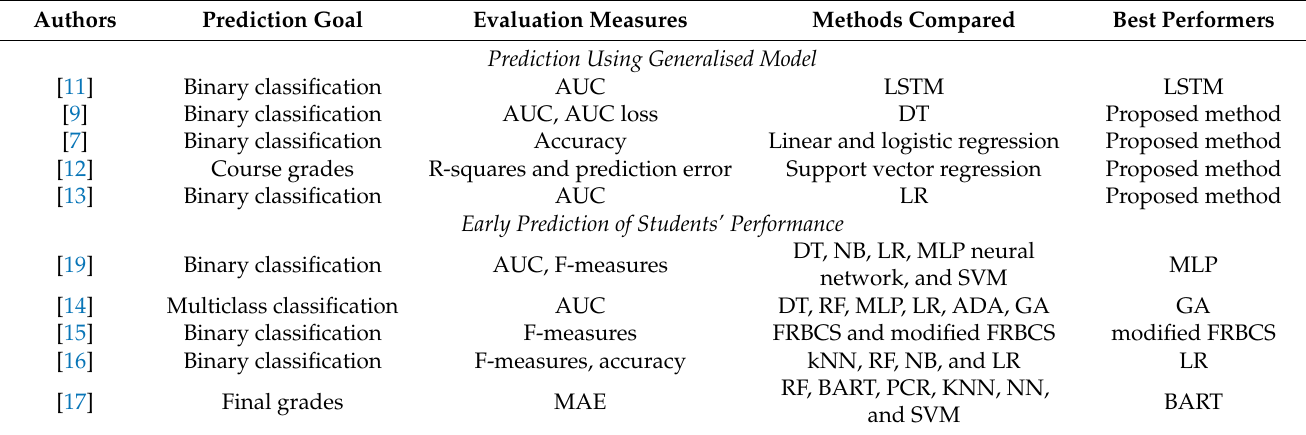
Table 1. Machine learning algorithms applied in educational